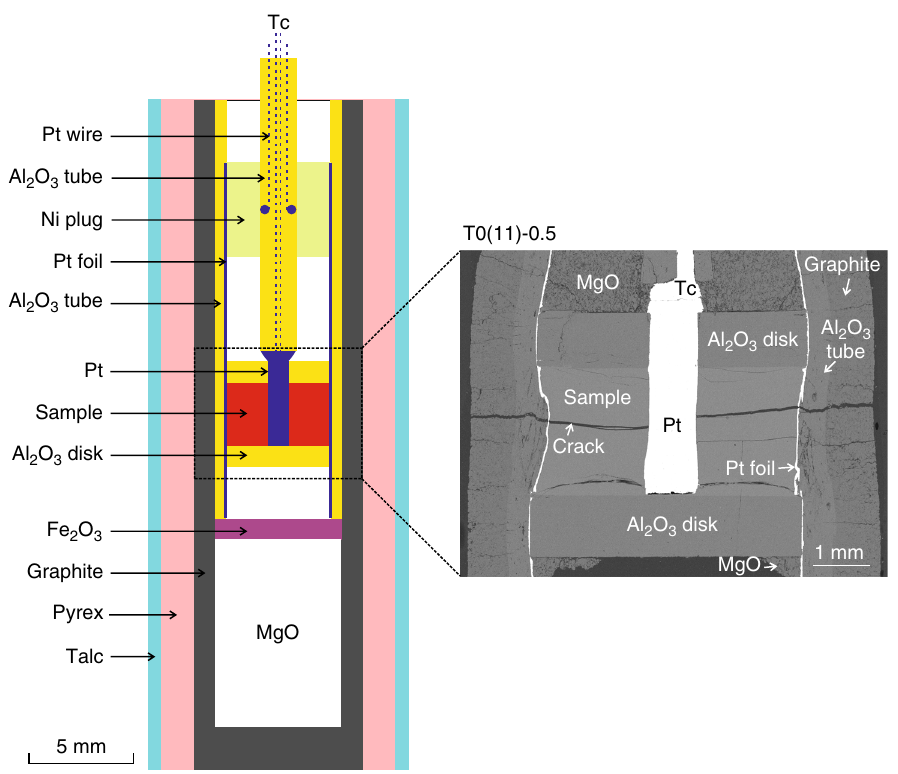
Fig. 2 Half-inch experimental assembly for piston-cylinder adapted to electrical conductivity measurements. It was modi fi ed after Sifré et al. 43 and Laumonier et al. 42 . The SEM image shows the inner structure of the assembly after the experiment on the sample